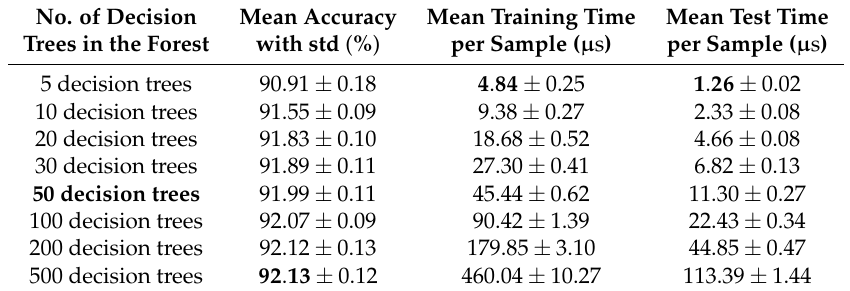
Table 3. Comparison of the RF configurations based on the numbers of decision trees in the